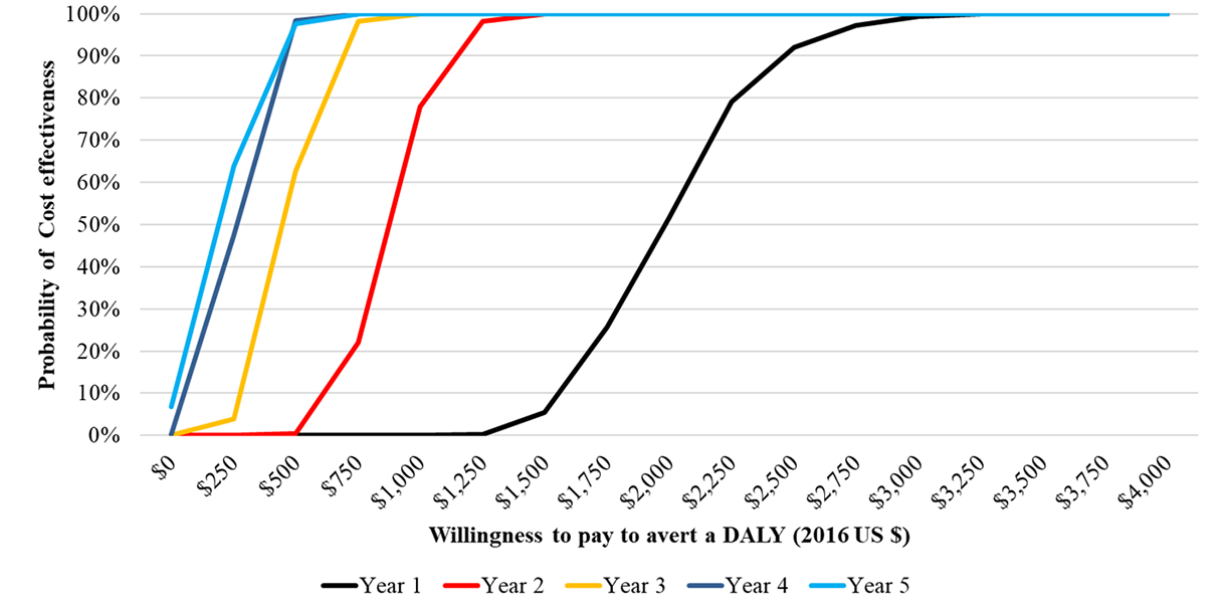
Figure 4. Incremental cost effectiveness acceptability curve of years 1-5 of MAMA implementation vs status quo in Gauteng, South Africa. Using the South Africa’s gross national income (GNI) per capita for 2015 of US $6,080 as the threshold, program activities have a 100% probability of being cost effective. At lower willingness pay thresholds, the probability of MAMA being cost effective increases over time as the number of users increases along with anticipated health effects. DALY: Disability adjusted life years.